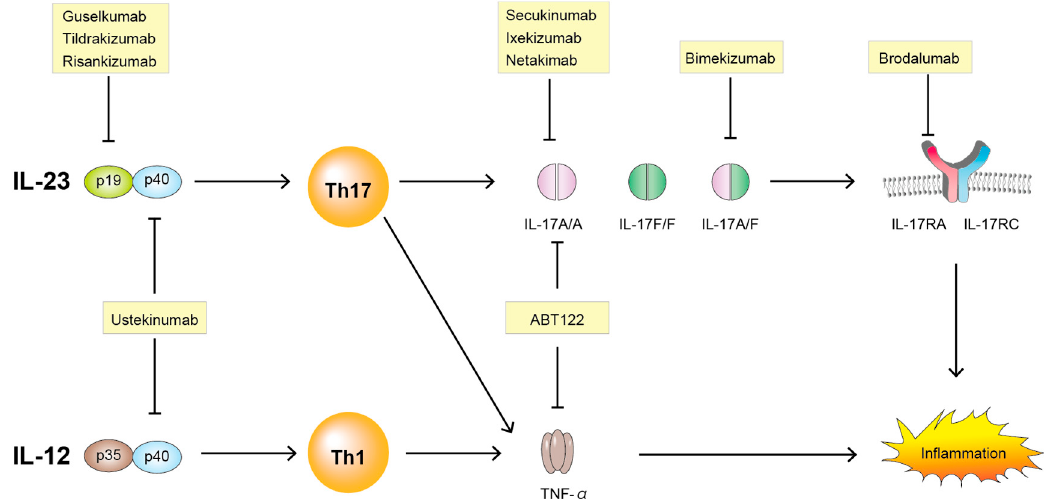
Figure 3. Targeting the IL-23 / IL-17 pathway. IL-23, interleukin-23; IL-12, interleukin-12; p19, p19 subunit of interleukin-23; p35, p35 subunit of interleukin-12; p40, p40 subunit of interleukin-12 or of interleukin-23; IL-17A, interleukin-17A; IL-17F, interleukin17F; IL-17RA, interleukin-17 receptor A; IL-17RC, interleukin-17 receptor C; Th1, T helper cell 1; Th17, T helper cell 17; TNF- α , tumor necrosis factor- α .